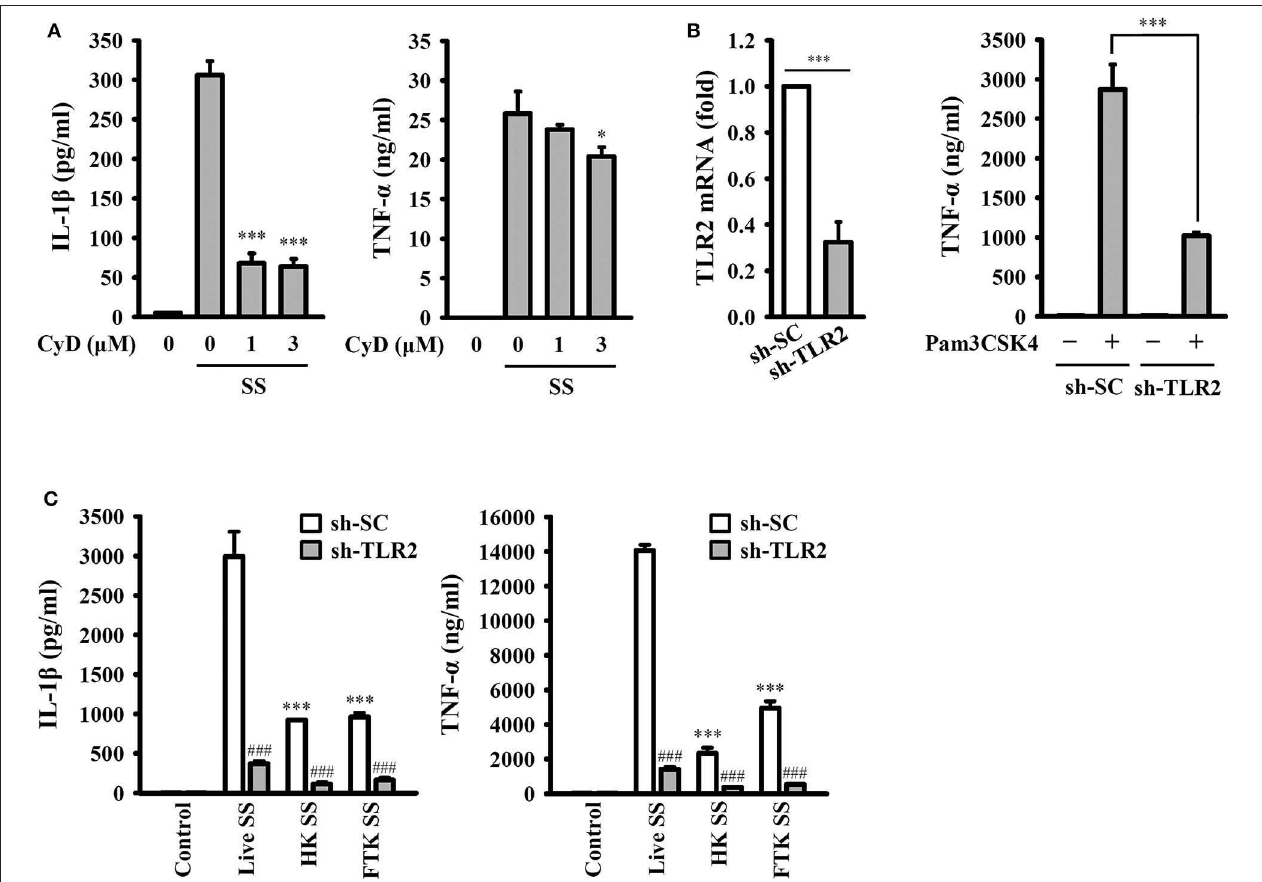
FIGURE 6 | Phagocytosis of live S. sonnei is required for the full activation of the NLRP3 inflammasome. (A) J774A.1 macrophages were primed with 1 µ g/ml LPS for 4h and then treated with cytochalasin D for 0.5h. The cells were then infected with 50 MOI S. sonnei for an additional 20h. The levels of IL-1 β and TNF- α in the supernatants were measured by ELISA. (B) The TLR2 mRNA expression of mock or TLR2 knockdown J774A.1 macrophages was measured by RT-qPCR. Mock or TLR2 knockdown J774A.1 macrophages were stimulated with 1 µ g/ml Pam3CSK4 for 6h. The levels of TNF- α in the supernatants were measured by ELISA. (C) Mock or TLR2 knockdown J774A.1 macrophages were primed with 1 µ g/ml LPS for 4h and then infected with 50 MOI live, heat-killed or freeze/thaw-killed S. sonnei for an additional 20h. The levels of IL-1 β and TNF- α in the supernatants were measured by ELISA. The ELISA data are expressed as the mean ± SD of four separate experiments. * and *** indicate significant differences at the levels of p < 0.05 and p < 0.001, respectively, compared to S. sonnei -infected cells (A) or live S. sonnei -infected cells (C) or as indicated (B) . ### indicates significant differences at the levels of p < 0.001 compared to sh-SC cells [one-way ANOVA with Dunnett’s multiple comparisons test in panels (A,C) ; two-tailed t -test in panel (B)